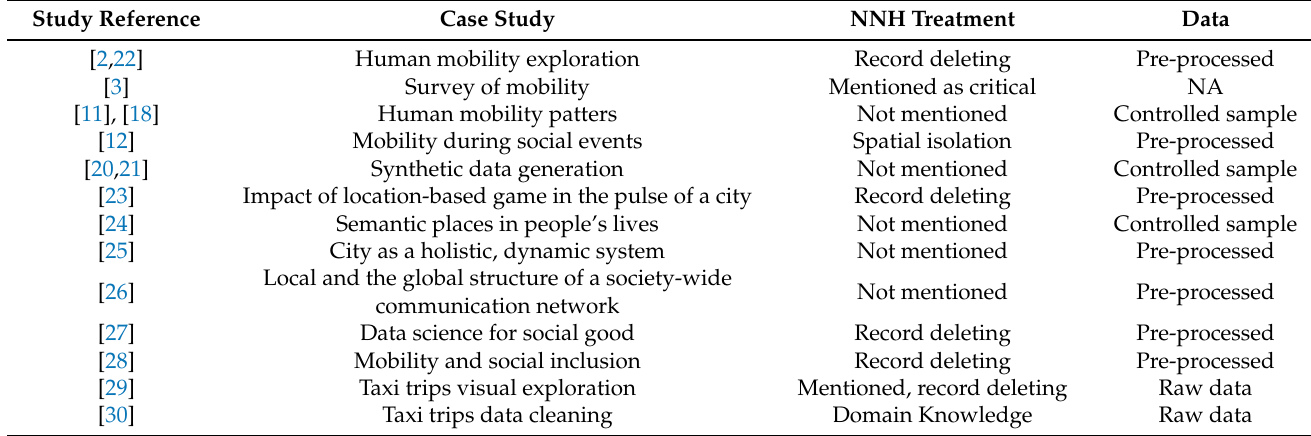
Table 1. Sample of some studies that use cellular data, their case studies, and the NNH’s management approach. Study